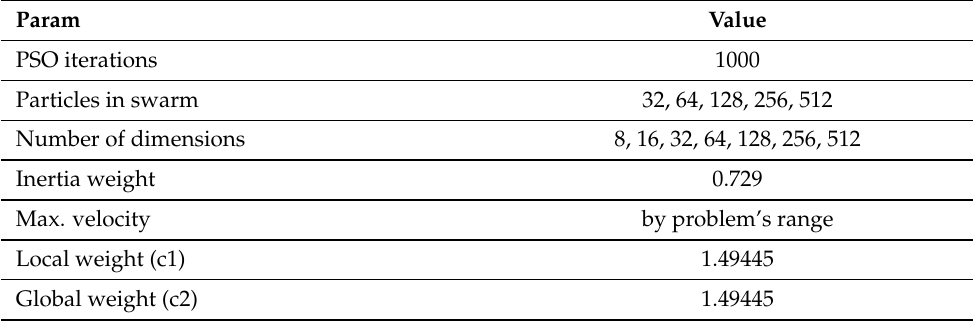
Table 1. PSO parameters during